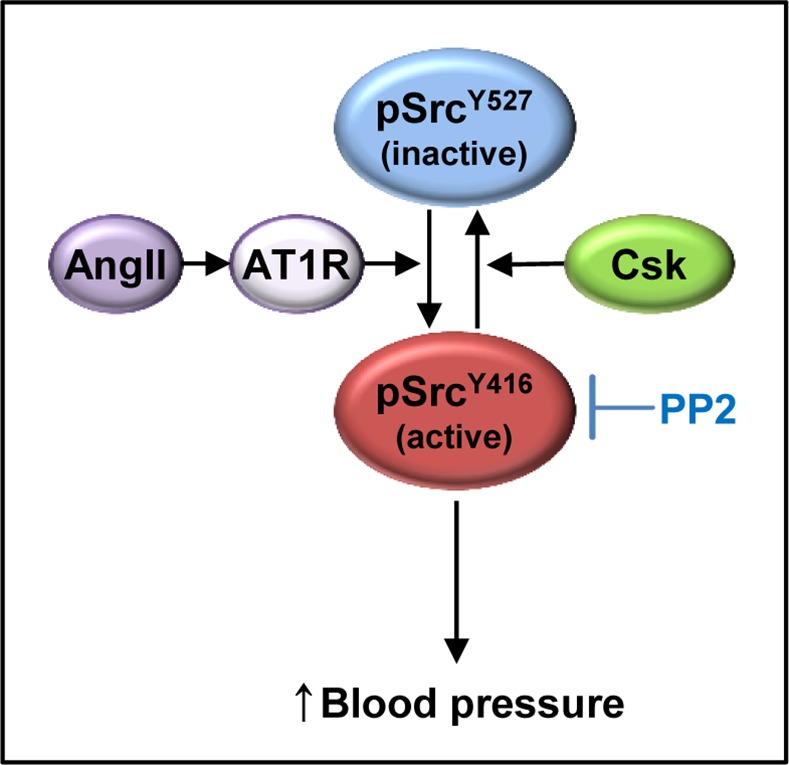
The working model of blood pressure regulation by Csk and Angiotensin II through Src.Angiotensin II (Ang II) increases blood pressure through angiotensin type 1 receptor (AT1R) dependent on the Csk/Src signal. Csk, a negative regulator of Src increases phosphorylation of SrcY527 (inactive) and decreases that of SrcY416 (active).